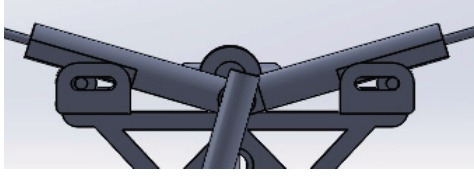
Figure 57. Prototype 2 flapping